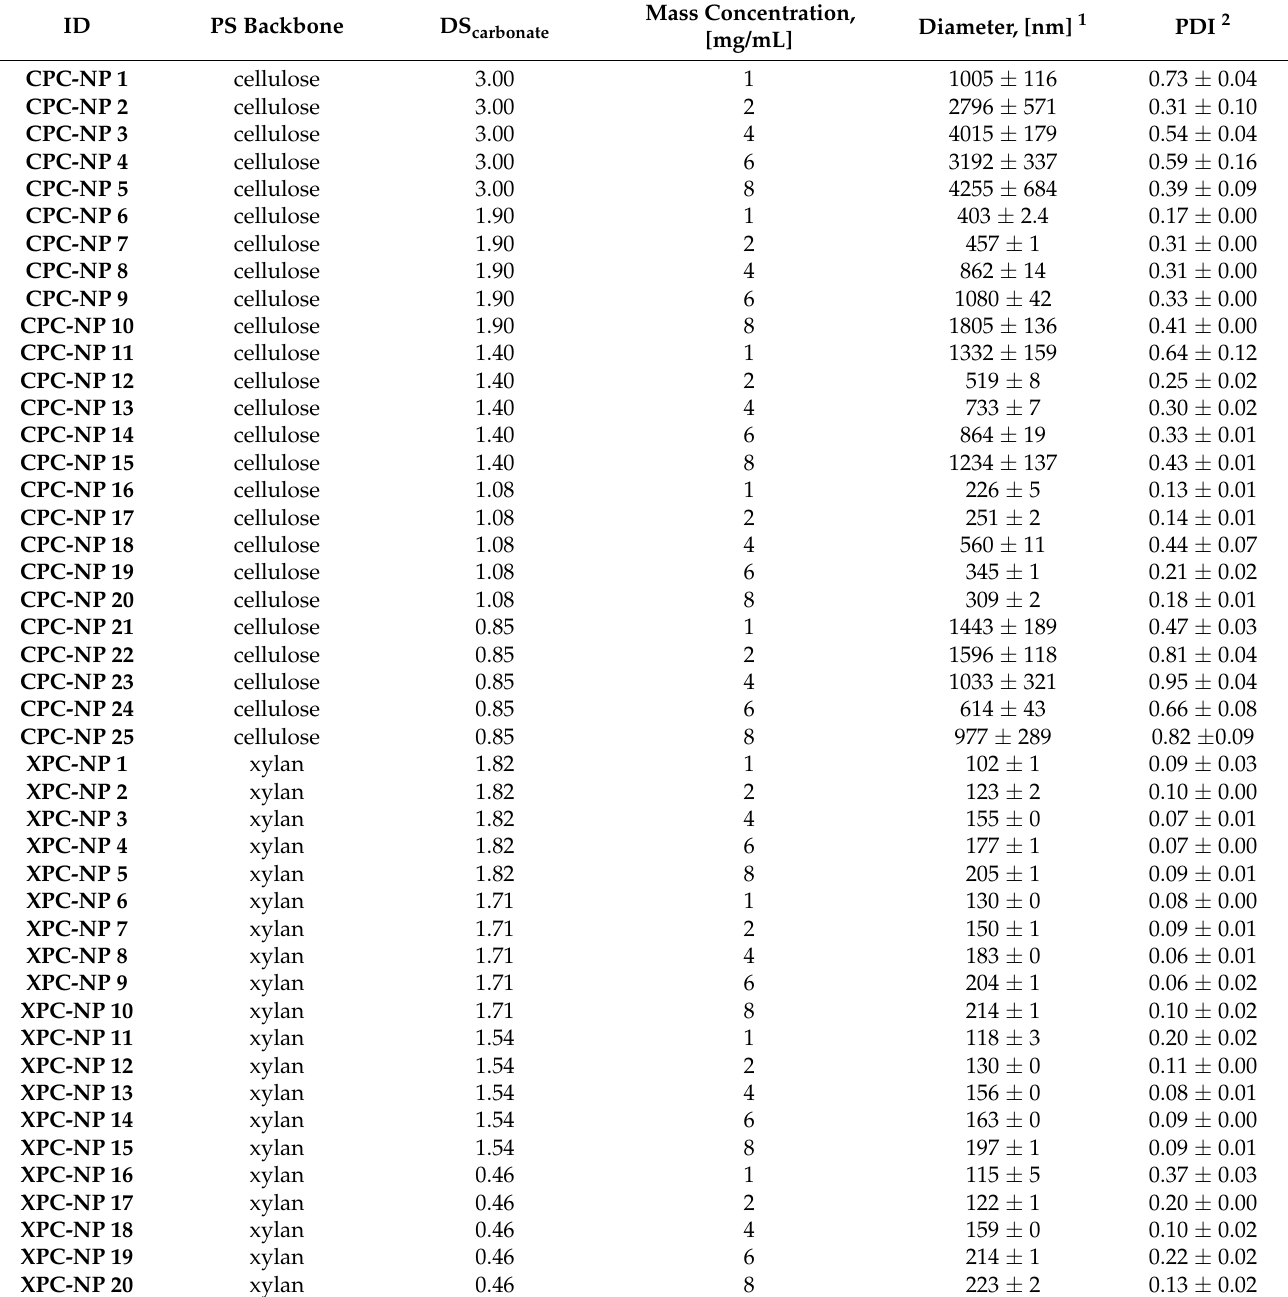
Table 1. Conditions for and results of the particle formation of polysaccharide (PS) phenylcarbonates with different backbones and degrees of substitution